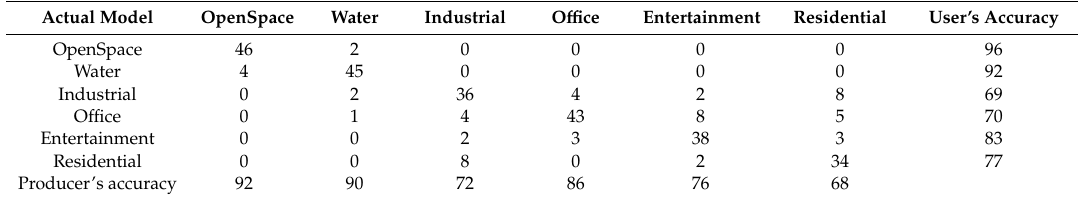
Table A5. Confusion matrix of random forest classified map using integration of remote and social sensing (without data cleaning).